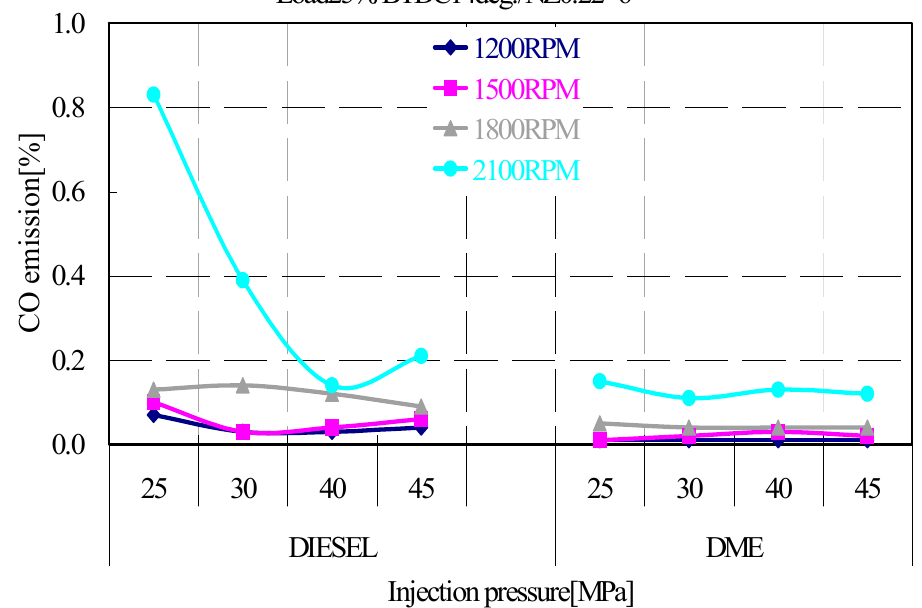
Figure 6. CO emission characteristics of diesel and DME engines without pilot injection as a function of injection pressure and engine speed.